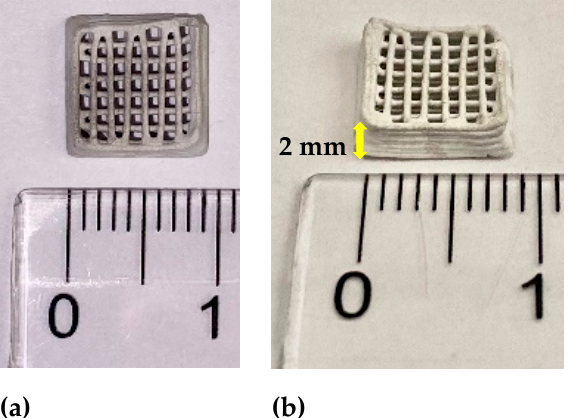
Figure 2. 3D structures based on ZnO-CNT composite manufactured by robocasting: ( a ) top view; ( b ) side-view.